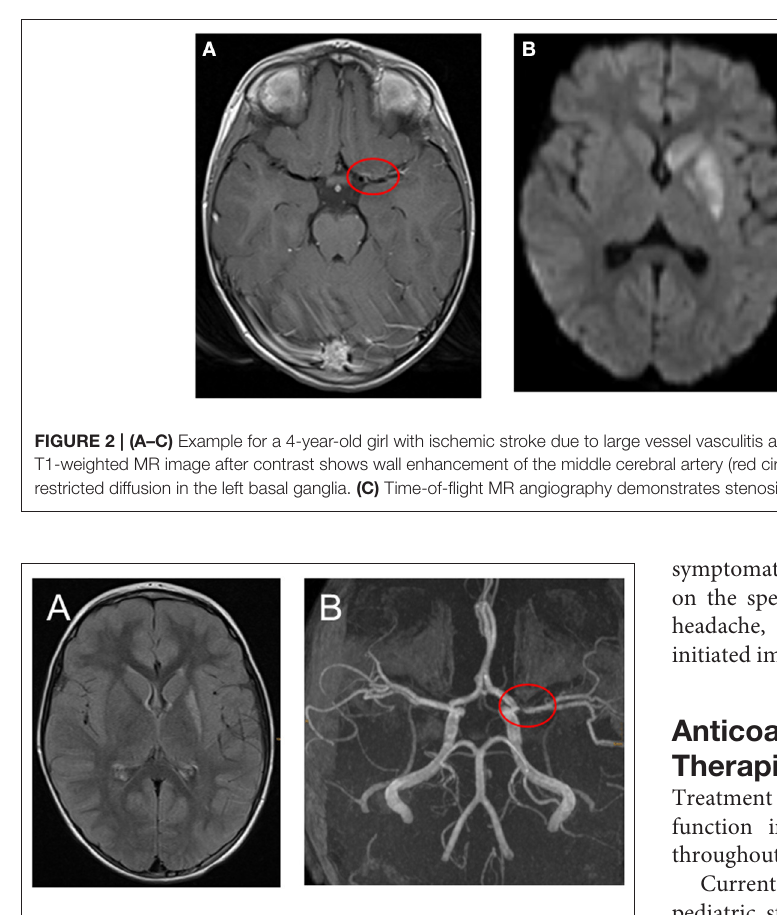
FIGURE 3 | (A,B) Fifteen months after the ischemic stroke with only very mild hemiparesis remained and no stroke relapses. (A) Transversal fluid-attenuated inversion recovery images demonstrate high signal in the left-sided basal ganglia. (B) Time-of-flight MR angiography still showing middle cerebral artery